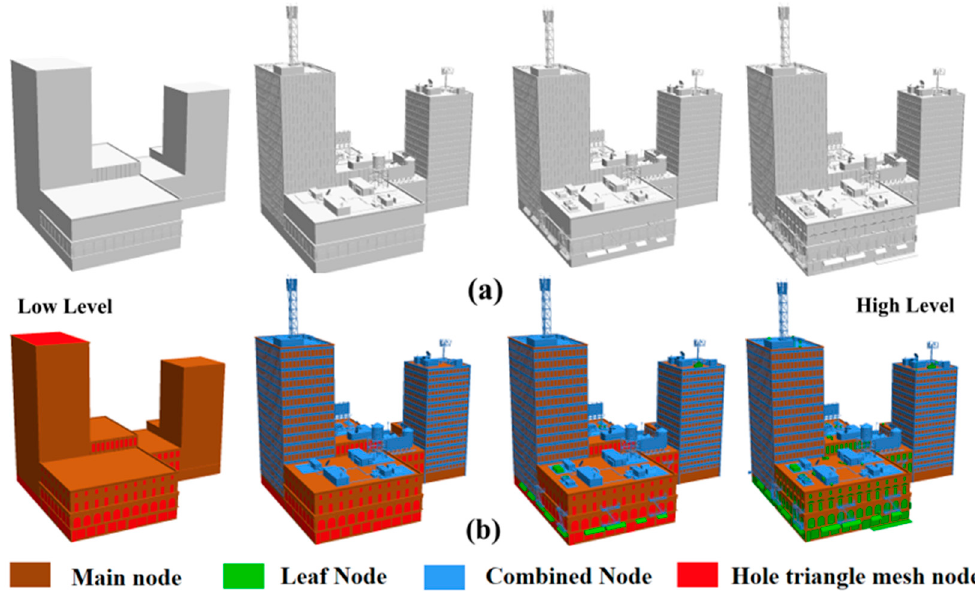
Figure 12. Model 1 refines from a low-level model to a high-level model by receiving increments. ( a ) Geometric structure change of Model 1, and ( b ) Model 1 receives various transmission nodes.